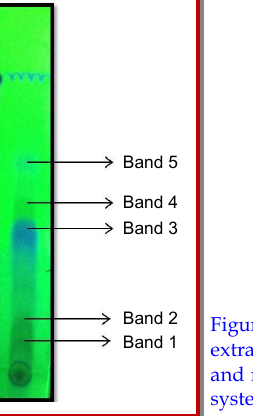
Figure 1: TLC separation of methanol extract of C. parviflorum . Ethyl acetate and methanol extract used as solvent system (8:2